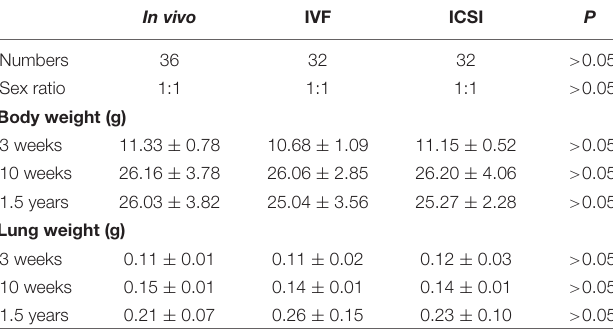
TABLE 1 | Comparison body and organ weight of ART and in vivo mice at three growth stages.